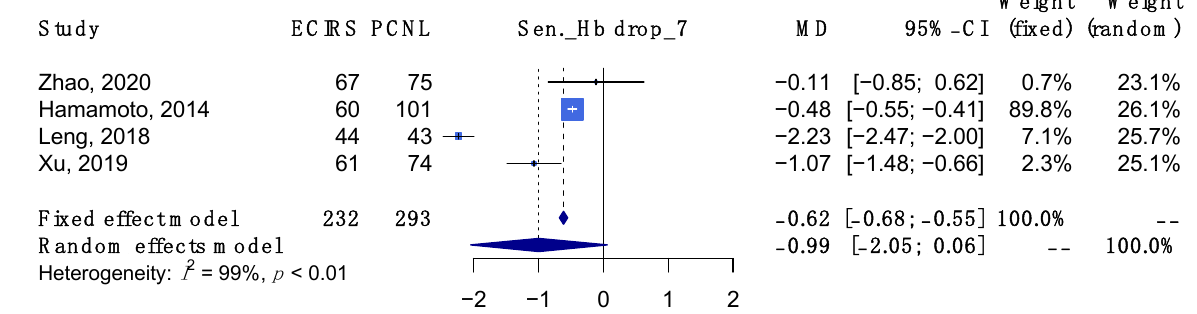
Figure A24. Sensitivity analysis of outcome regarding hemoglobin drop. ([18,19,22,23])